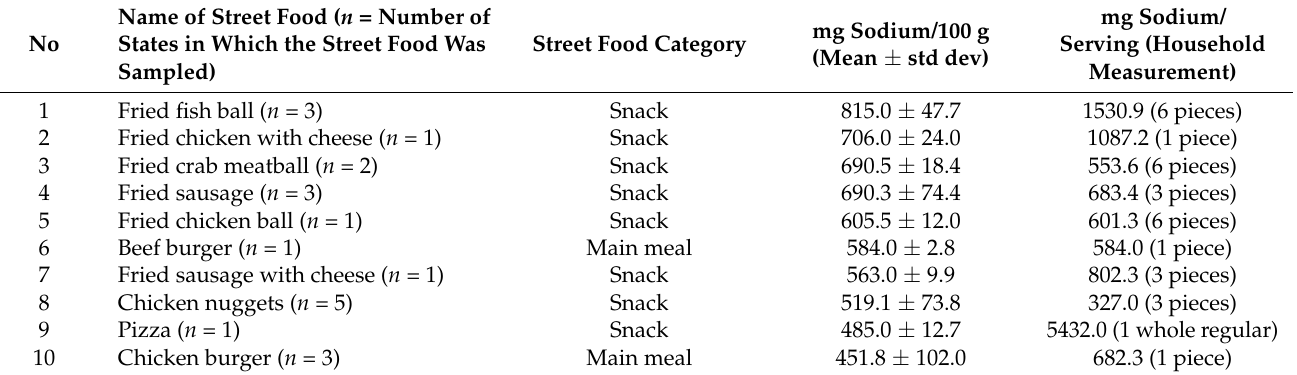
Table 3. Sodium content in processed food prepared as street